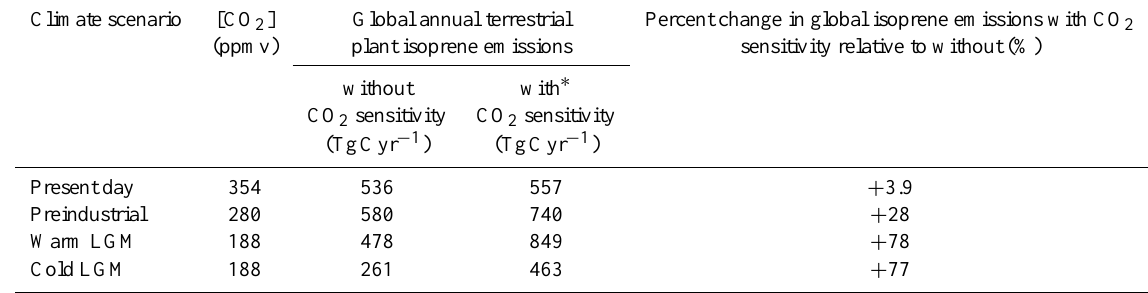
Table 1. Atmospheric CO 2 concentrations and global annual terrestrial plant isoprene emissions for each climate scenario. Climate scenario